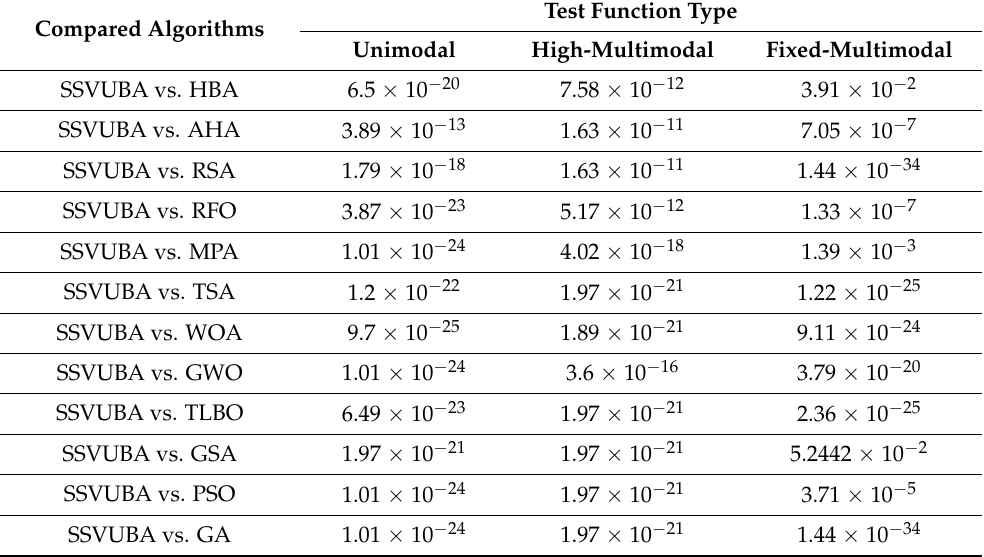
Table 5. p -values results from the Wilcoxon sum rank test. Compared